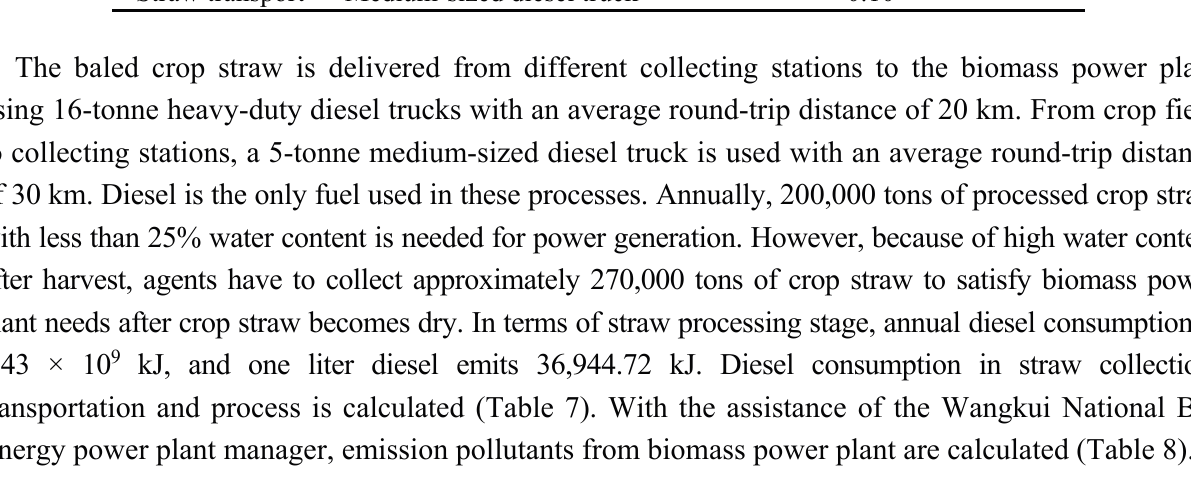
Table 7. Diesel consumption in straw pre-treatment stages.